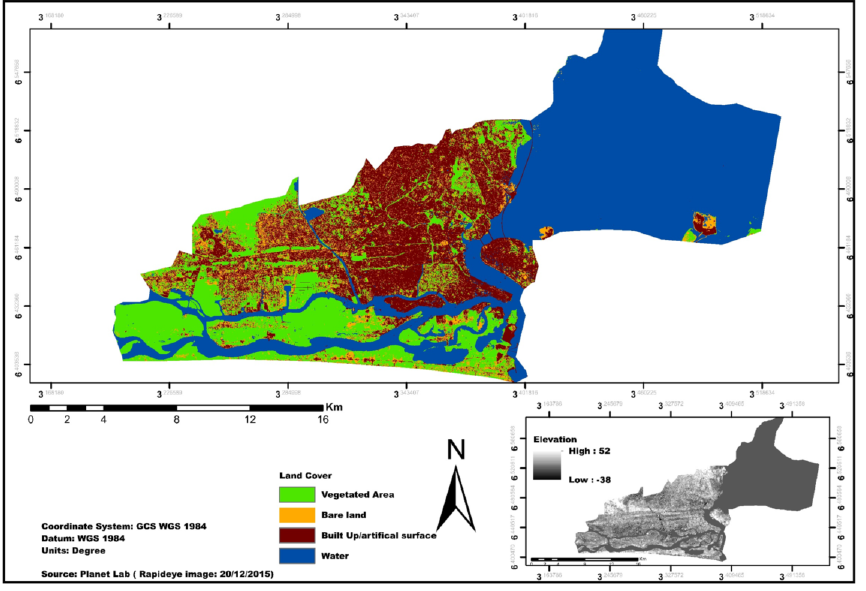
Figure 2. Landcover map and DEM of the study area in the city of Lagos. The landcover map is based on classified RapidEye data acquired on 20 December 2015.